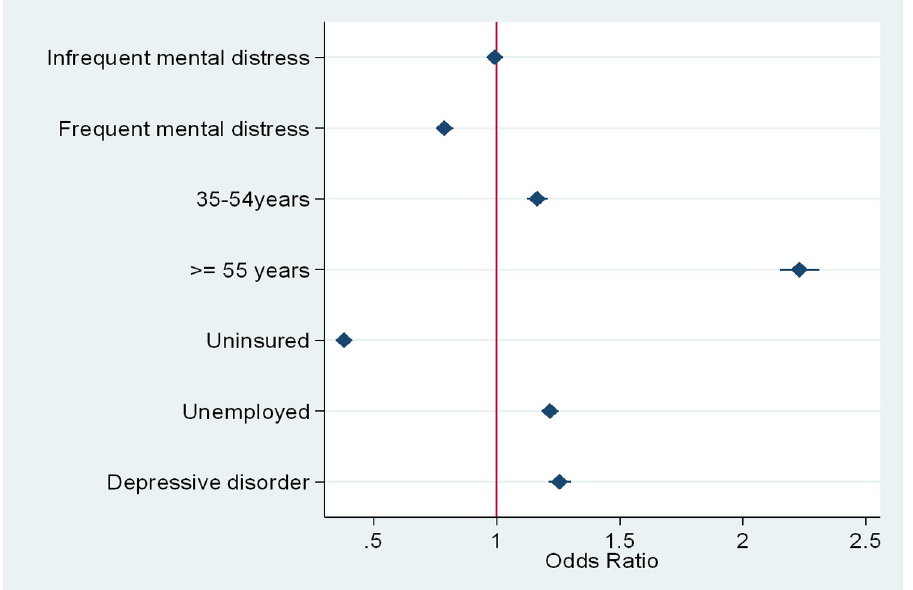
Fig 1. Forest plot of odds ratio for outcome